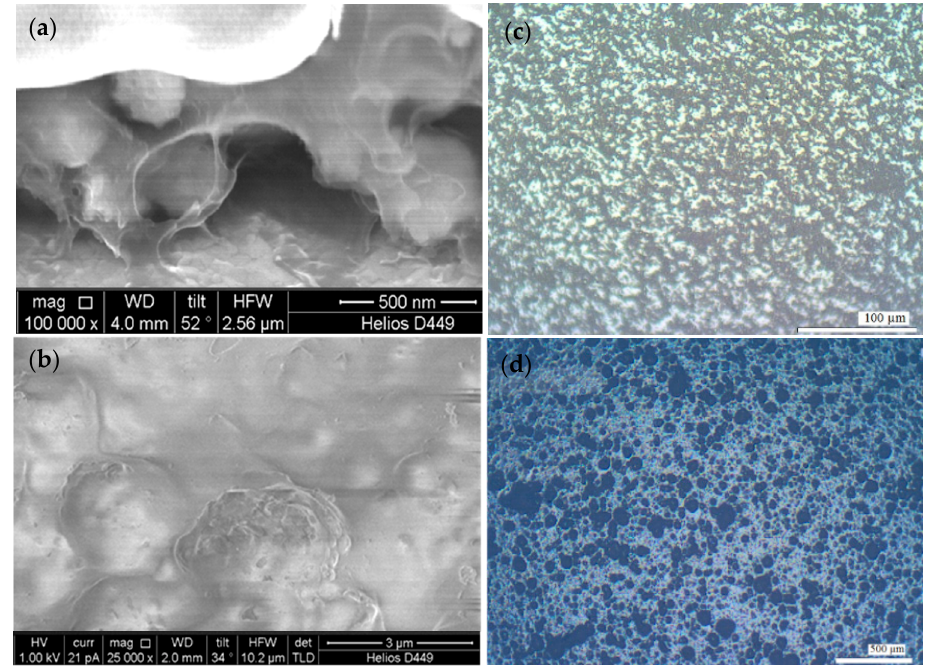
Figure 2. SEM image of section ( a ) and surface ( b ) of composite film and microscope-images of the composite surface: sample was obtained after ultrasonic treatment and decantation time of 20 days ( c ); sample was obtained from a suspension that was not subjected to ultrasonic treatment ( d ).